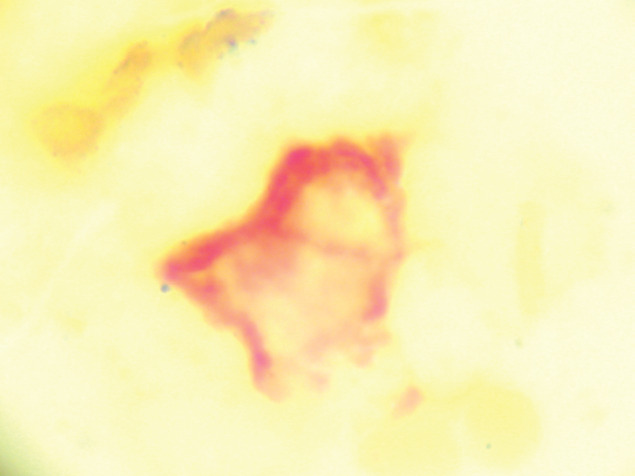
Circulating tumour cells, expressing carcinoembryonic antigen (red) and negative for membrane CD45.